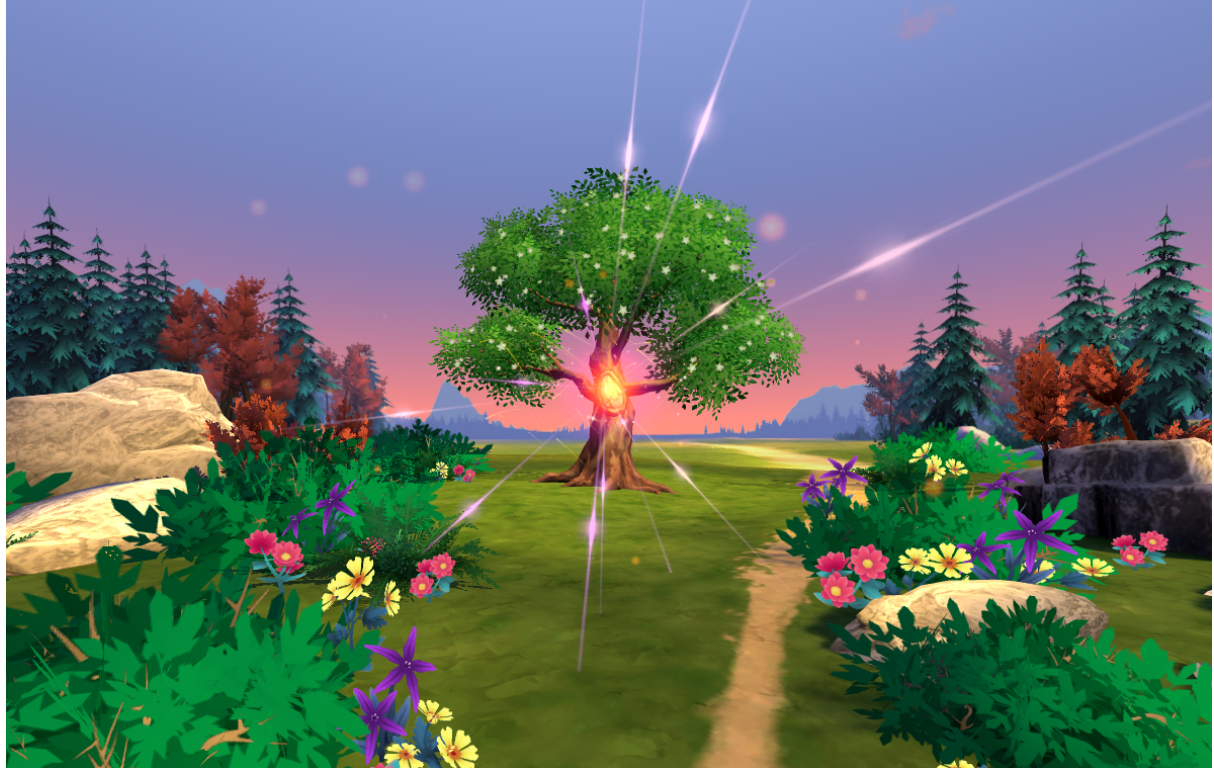
Figure 3. Image of Pain Care virtual reality content that visualizes the user’s